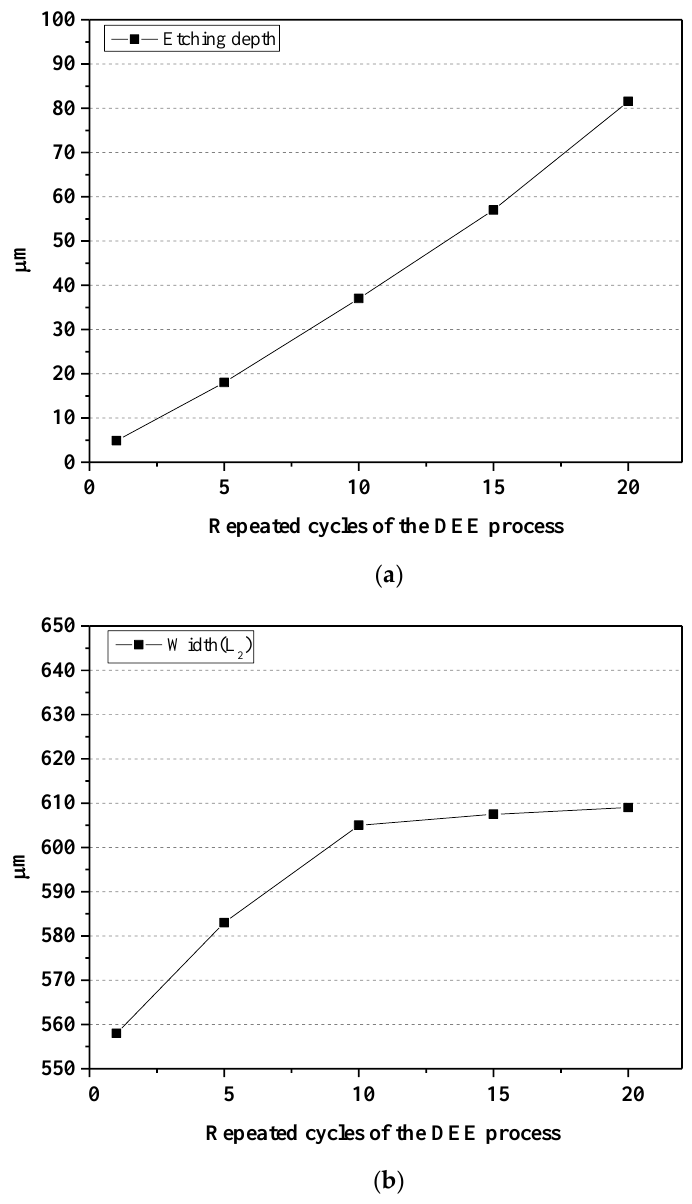
Figure 9. Variation of the etching depth and width (L 2 ) according to repeated cycles of the DEE process: ( a ) etching depth and ( b ) width (L 2 ).